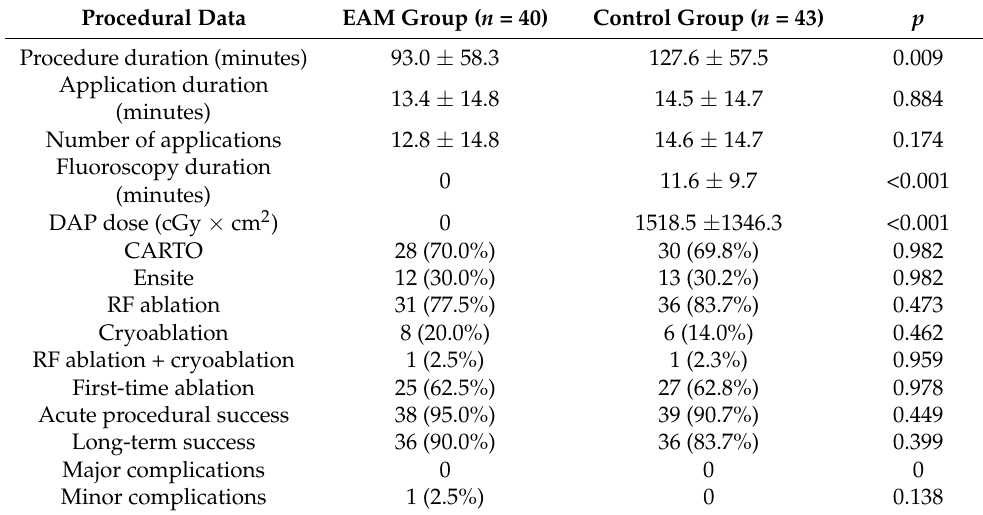
Table 2. Procedural data and results (the values are means ± standard deviation). DAP—dose area product, EAM—electroanatomic system,